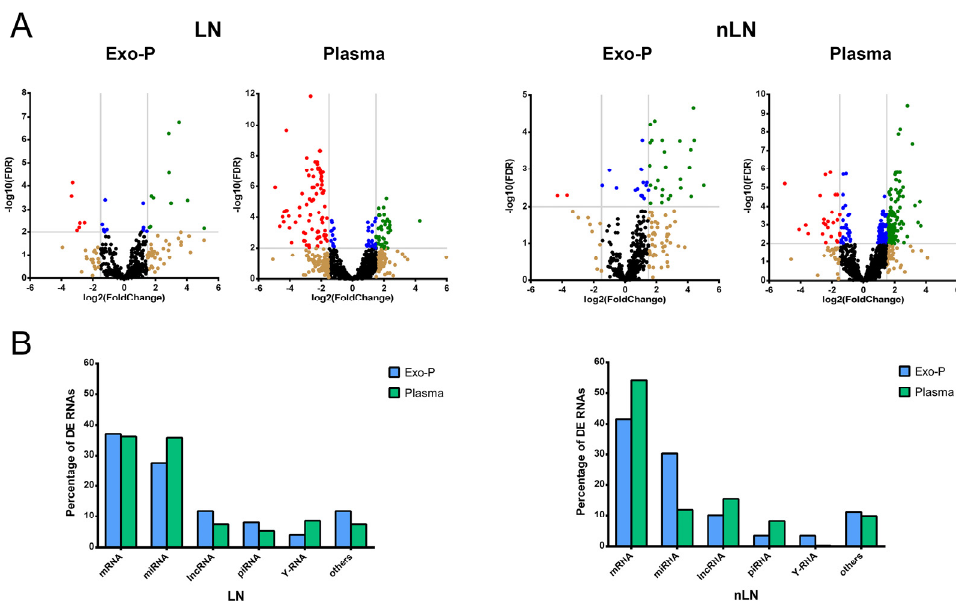
Figure 1. Differentially expressed RNAs in SLE patients with or without renal damage in each biological fraction compared to control subjects. ( A ) Volcano plot depicts significantly altered RNAs found in LN or nLN. Each dot represents an RNA; non-significant false discovery rate (FDR > 0.05) and log2 fold-change ≥− 1.5 or ≤ 1.5) in black, log2 fold-change ≤− 1.5 or ≥ 1.5 in brown, signi fi cant FDR in blue and signi fi cant FDR and log2 fold-change ≥ 1.5, green (up-regulated) or ≤− 1.5 in red (down-regulated). The threshold do tt ed line for − log10(FDR) it was <0.05 and for log2 fold-change was ≤ 1.5 or ≥− 1.5, and; ( B ) Bar graph of RNA subtype percentages according to the two bio fl uids in LN and nLN. DE: di ff erentially expressed; Exo-P: plasma exosomes; LN: lupus nephritis; nLN: non lupus nephritis. lncRNA: long non-coding RNA; miRNA: microRNA; mRNA: messenger RNA; piRNA: PIWI-interacting RNA.